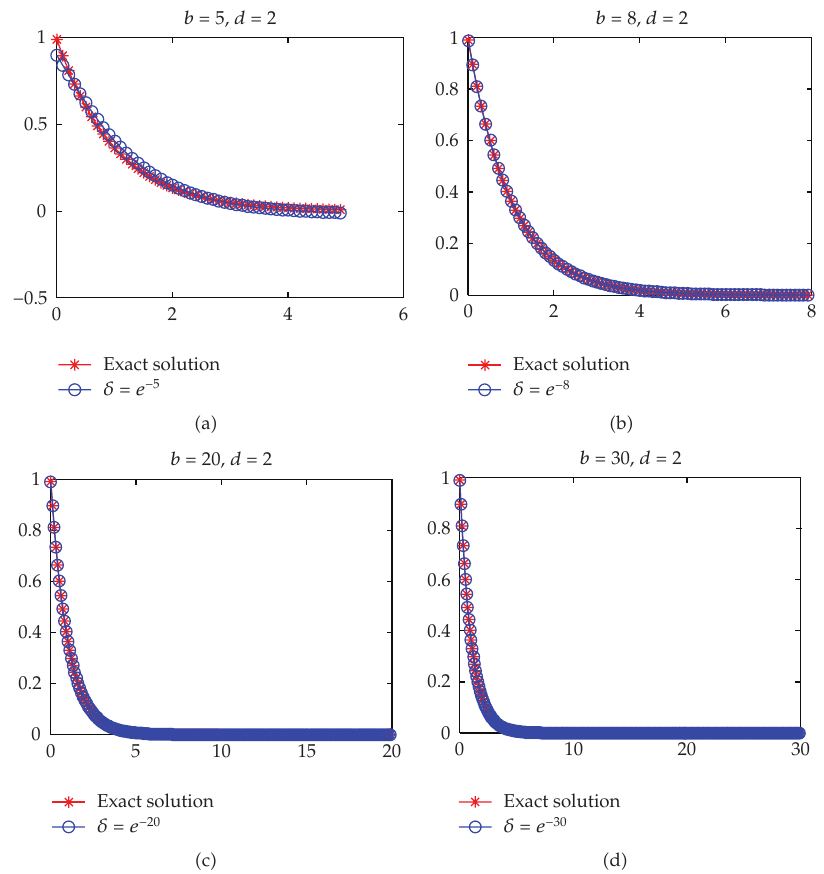
Figure 13: Example 3.13: the stability of the approximate